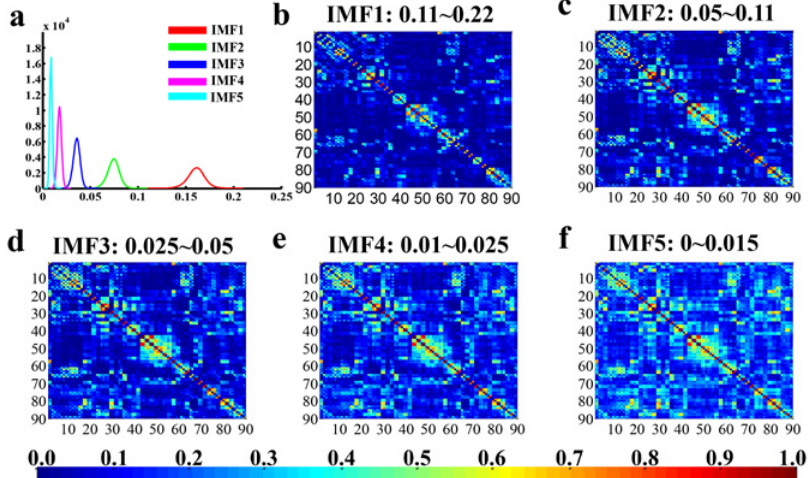
Fig 2. Schematic of frequency distribution and specificity of functional connectivity networks. Fig 2a represents the histograms of HWF of IMF1 to IMF5 using CEEMD (n = 161, ε 0 = 0.04), which is the same as Fig 1d. These IMFs occupy different frequency bands in a descending order (IMF1: 0.11 – 0.22 Hz; IMF2: 0.05 – 0.11 Hz; IMF3: 0.025 – 0.05 Hz; IMF4: 0.01 – 0.025 Hz; IMF5: 0 – 0.015 Hz, respectively). Fig 2b – 2f denote the group-mean inter-regional correlation matrices of each IMF component (AAL template, 90×90 correlation matrix, only the positive value was presented), and the number from 1 to 90 represents the corresponding ROI in AAL template, for details, refer to Table